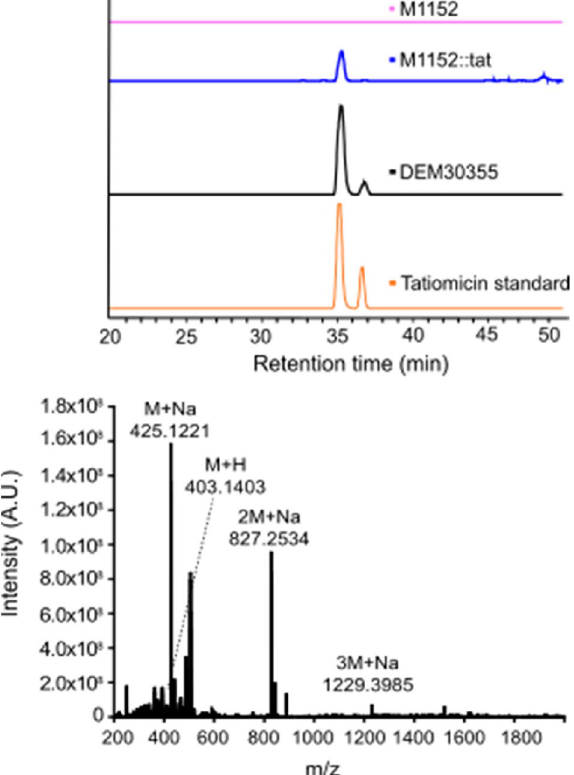
Figure 5. Detection of tatiomicin from the fermentation of heterologous host S. coelicolor M1152::tat. Top) Extracted ion chromatogram (EIC) based on m/z = 827.25. S. coelicolor M1152 (purple), S. coelicolor M1152::tat (blue), Amycolatopsis sp. DEM30355 (black) and tatiomicin standard (red). Bottom) MS spectrum of tatiomicin ( 3 ) purified from the heterologous host S. coelicolor